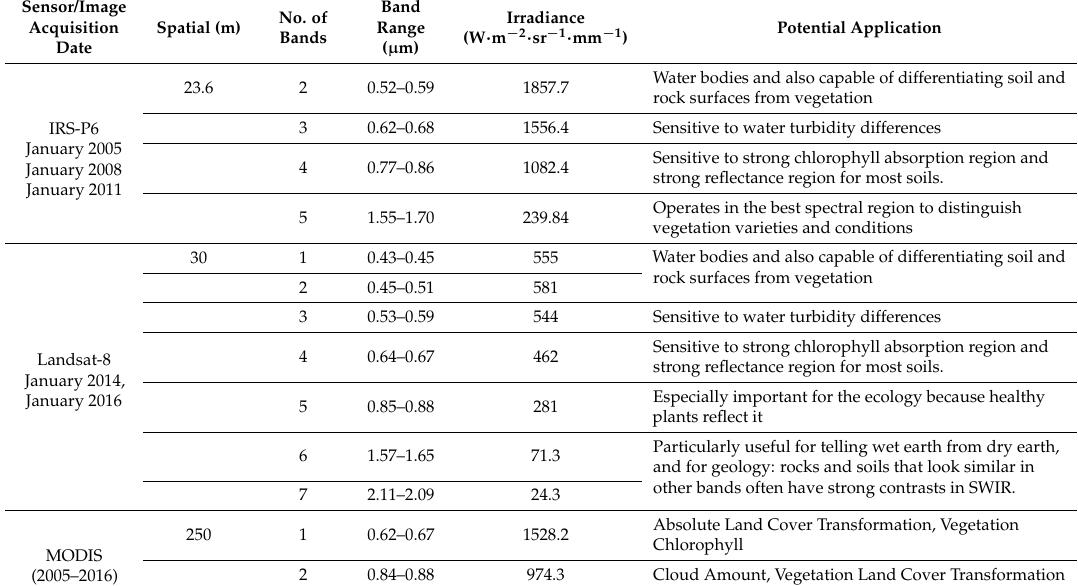
Table 1. Characteristics of satellite data used in this